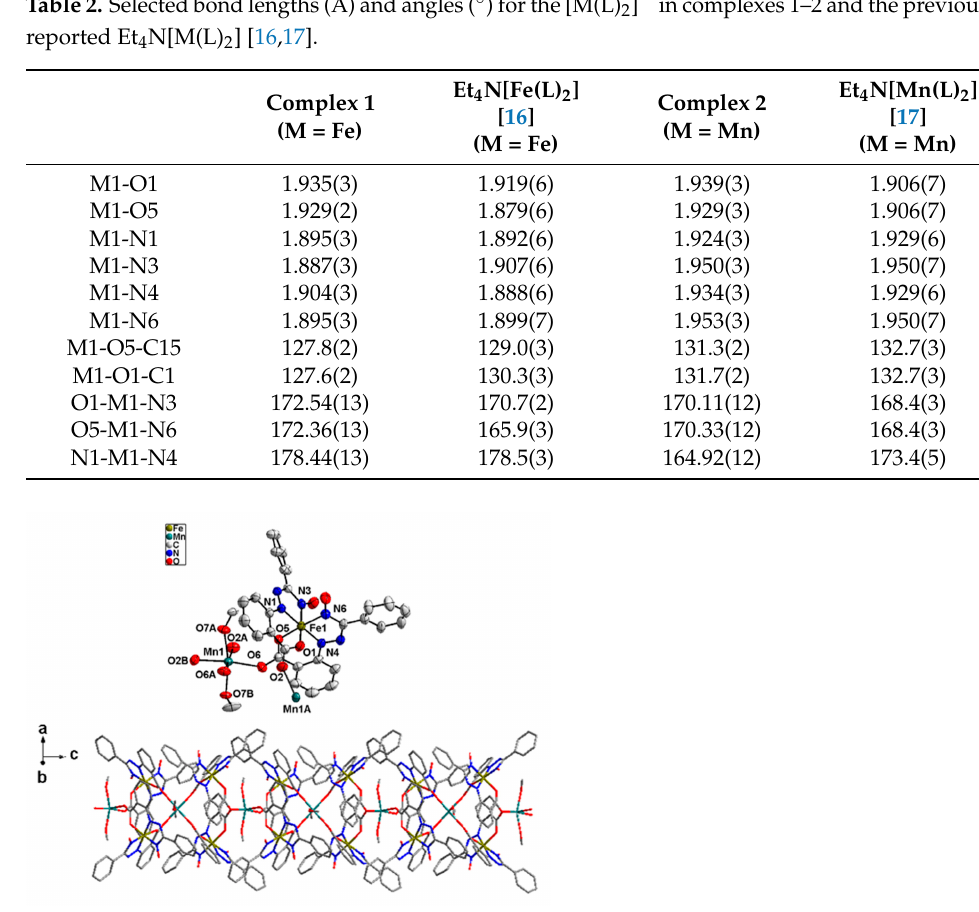
Figure 1. Molecular structure of complex 1. Top: thermal ellipsoids. Bottom: The 1D chain. Hydrogen atoms and solvent molecules are omitted for clarity. Fe: dark yellow; Mn: cyan; C: gray; N: blue; O: red.